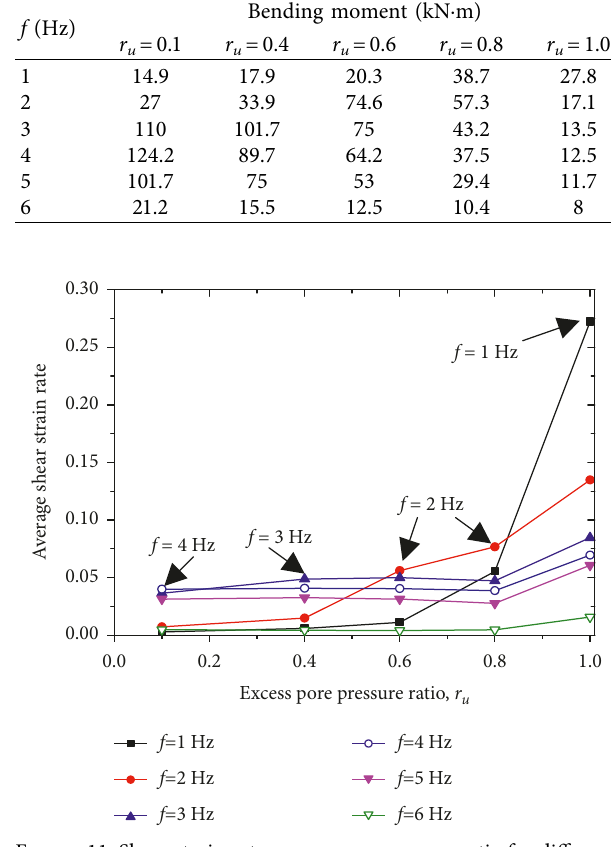
Table 1: The bending moment of pile in different loading frequency (kN m). ·